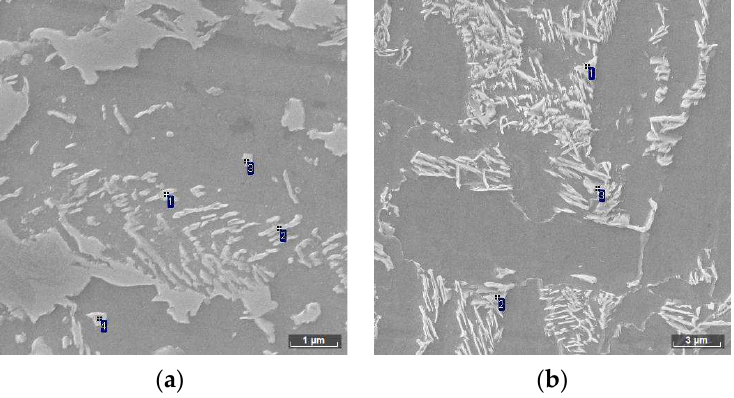
Figure 12. SEM images of carbides in segregations ( a ) and in base metal ( b ) in HRPB. Table 5. Chemical composition of carbides in segregations and base metal of the hot-rolled pipe billet (HRPB) sample, wt. %. Zone